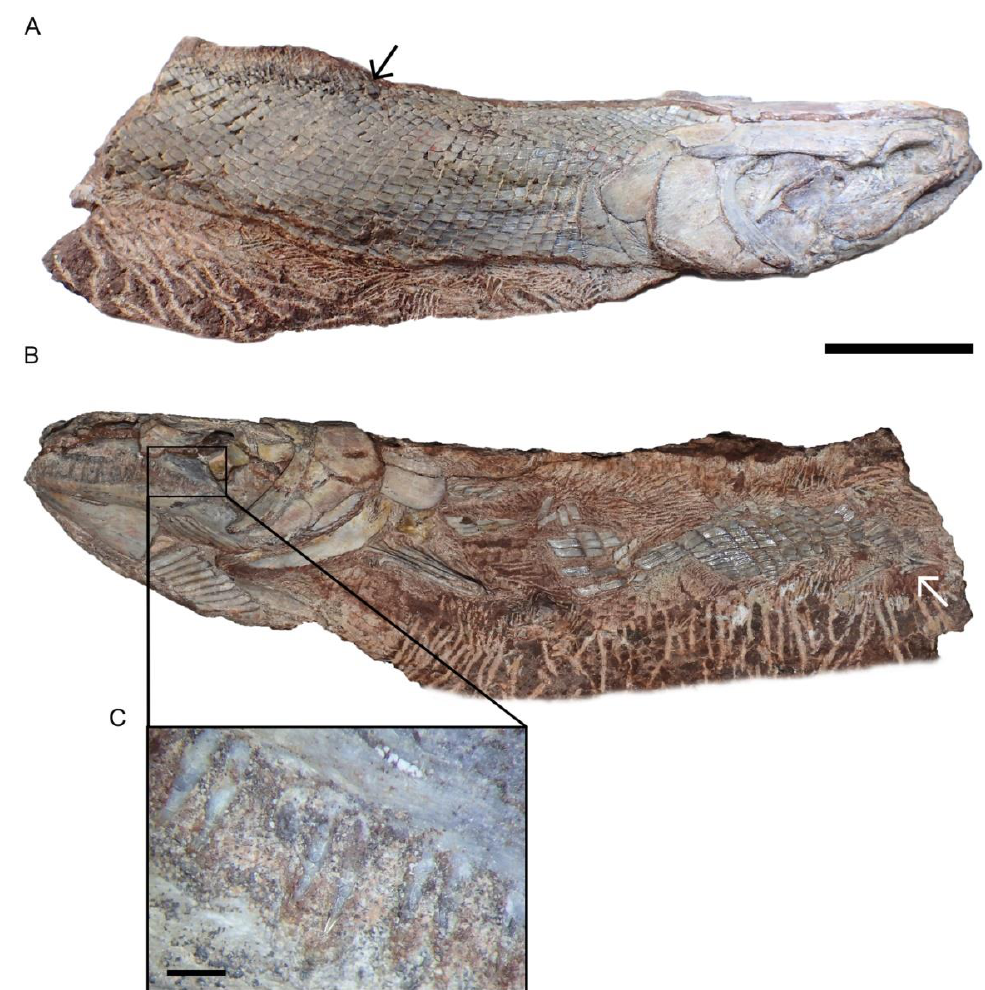
Figure 5. Holotype of Khoratamia phattharajani gen. et sp. nov., NRRU-F01020023: ( A ) photograph of the complete specimen in right lateral view, an arrow indicating the origin of the dorsal fin; ( B ) left lateral view, a white arrow indicating the position of the pelvic fin. The black box indicates the area enlarged in ( C ) (close-up of the teeth from a maxilla). Scales bars: 2 cm ( A , B ); 0.1 cm ( C ).